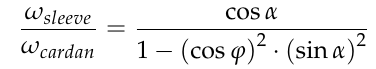
Figure 4. Rotary valve flow areas trends as function of the relative angular position between the spool and the sleeve.